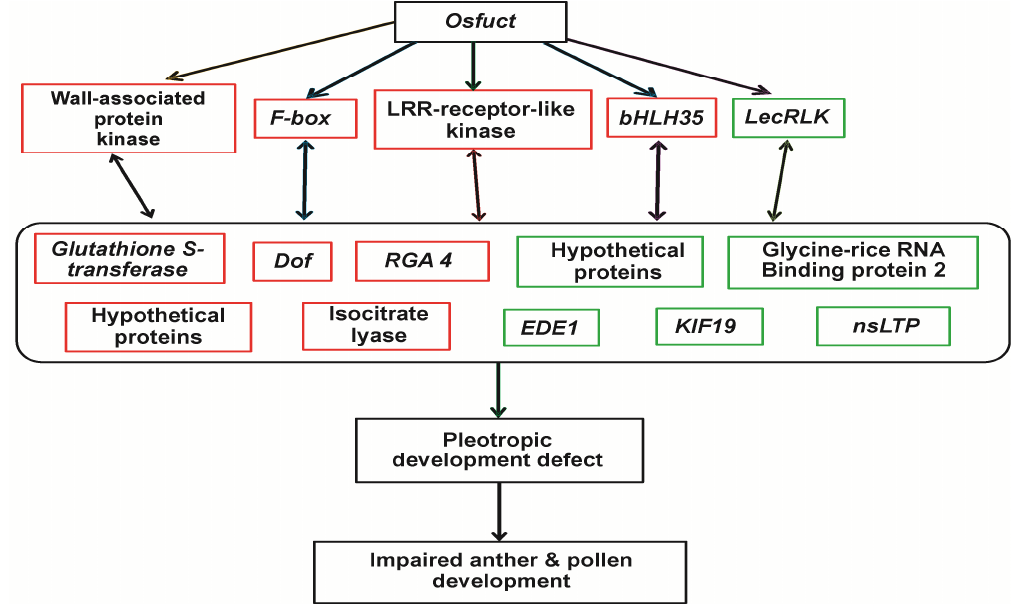
Figure 7. Possible function of Osfuct gene in growth, anther, and pollen development in rice. All up and downregulated genes together may affect growth and development in rice. Upregulated genes are in the red box and downregulated genes are in the green box. LecRLK, lectin receptor-like kinase; LRR-RLK, leucine-rich repeat receptor-like kinase; bHLH, basic/helix-loop-helix; DOF, DNA-binding one zinc finger; nsLTPs, non-specific lipid-transfer proteins; RGA4, resistance; EDE1, ENDOSPERM DEFECTIVE 1; KIF19, kinesin-like protein 19.